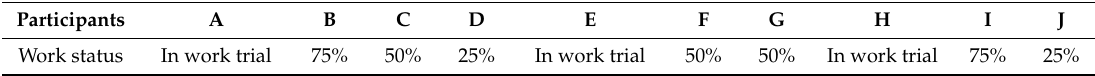
Table 5. Levels of work re-entry at 9 months after start of the work